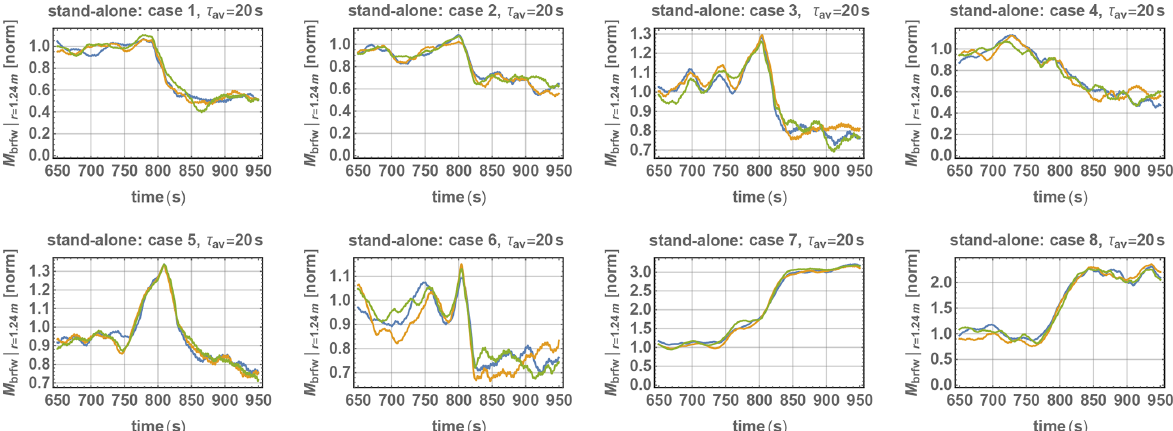
Figure 20. Stand-alone CMM/Flex5 simulations: normalized blade-root flap-wise bending moment [ M brfw ] near base ( r = 1 . 24m) for each blade (blue/gold/green); loads are normalized by respective pre-ramp mean value.